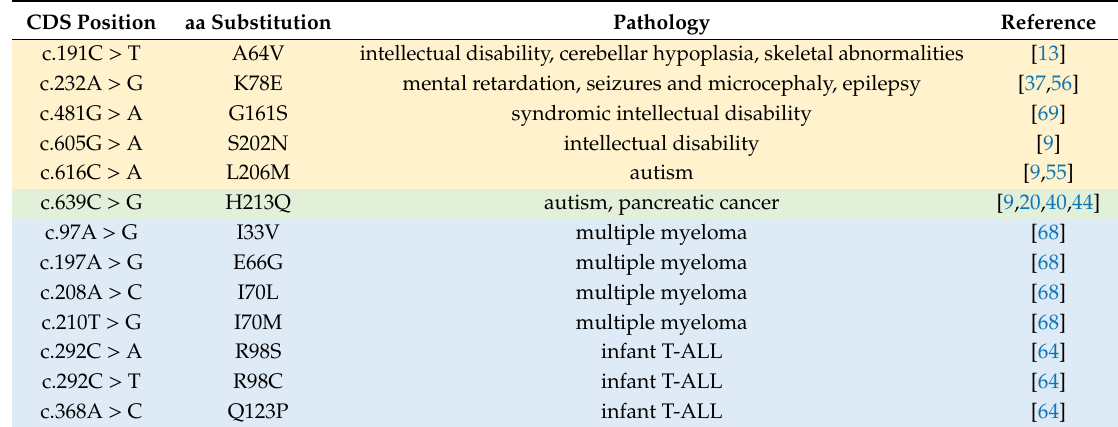
Table 1. RPL10 variants described in human pathology; rows with a yellow background are those containing information of RPL10 mutations in inherited diseases, rows in light blue are those related to cancer, the row in green is related to both. CDS, coding sequence; aa, amino